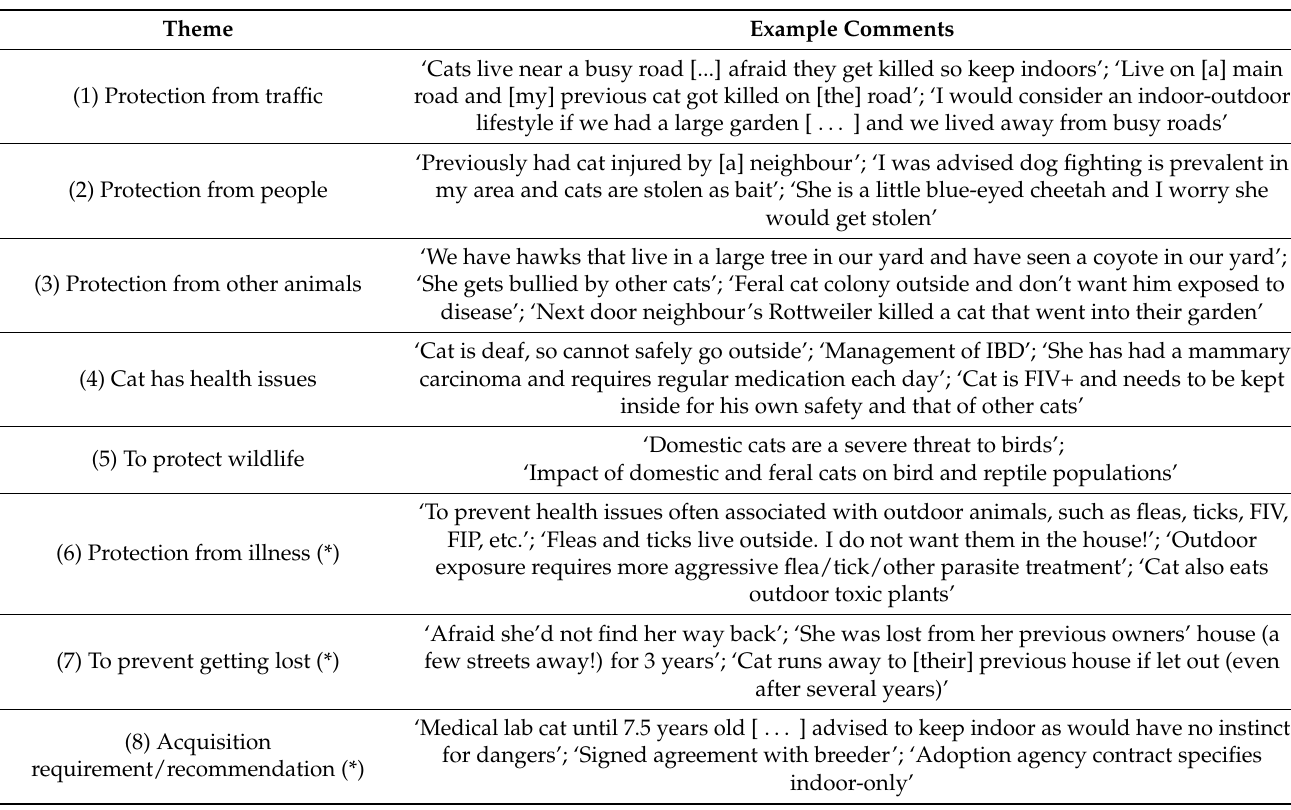
Table 9. Example quotes from owners used to create the 11 indoor-only rationale